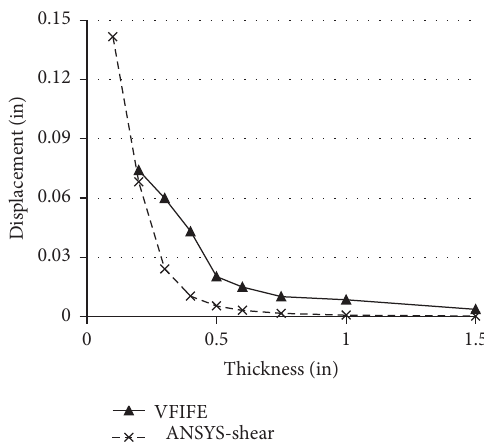
Figure 4: Comparison of vertical displacements of outer-edge nodes with diferent thicknesses (mesh size is 0.10in).